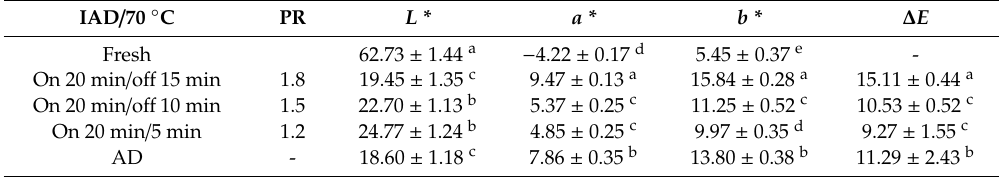
Table 2. Colour change of litchi dried by drying schemes with di ff erent pulse ratios. IAD / 70 ◦ C PR L * a * b * ∆ E Fresh 62.73 ± 1.44